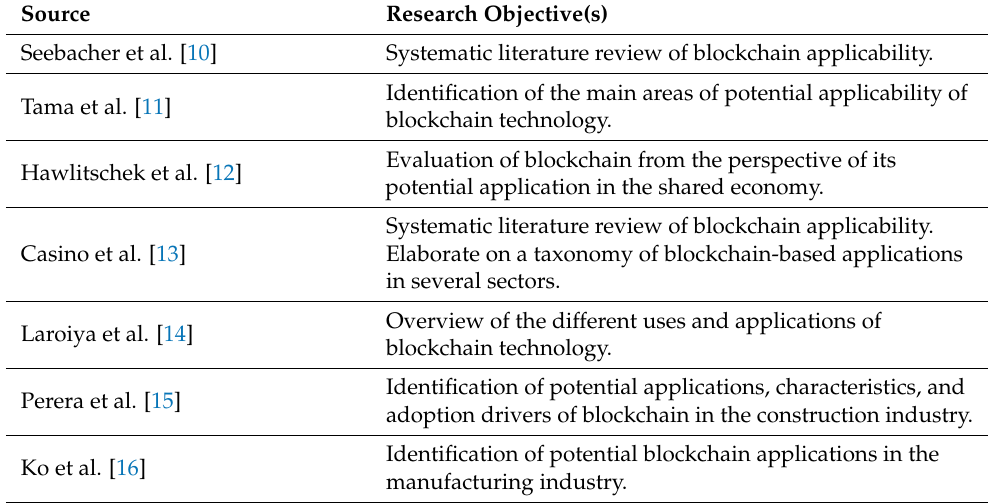
Table 1. Applications investment by company size